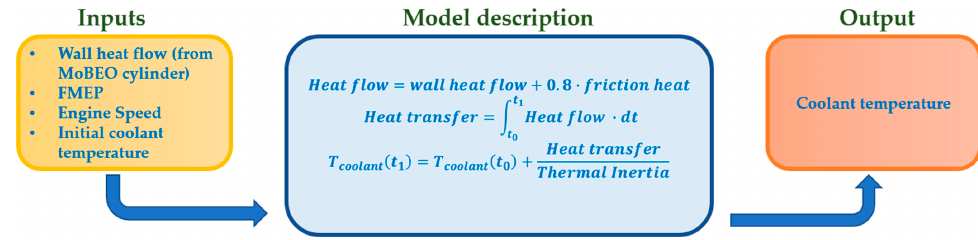
Figure 6. Coolant temperature: model description.